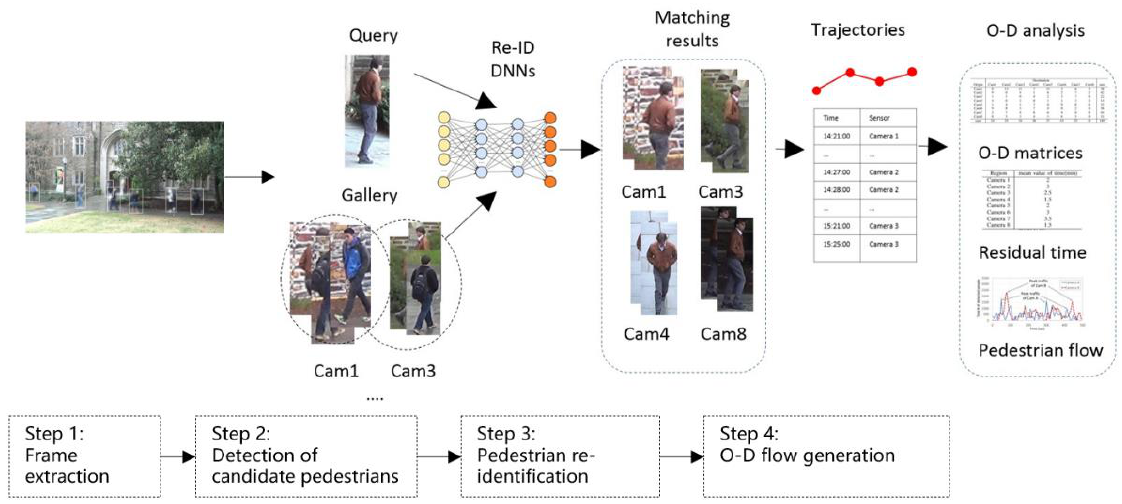
Figure 2. The flow chart of the method. Image source: DukeMTMC dataset.